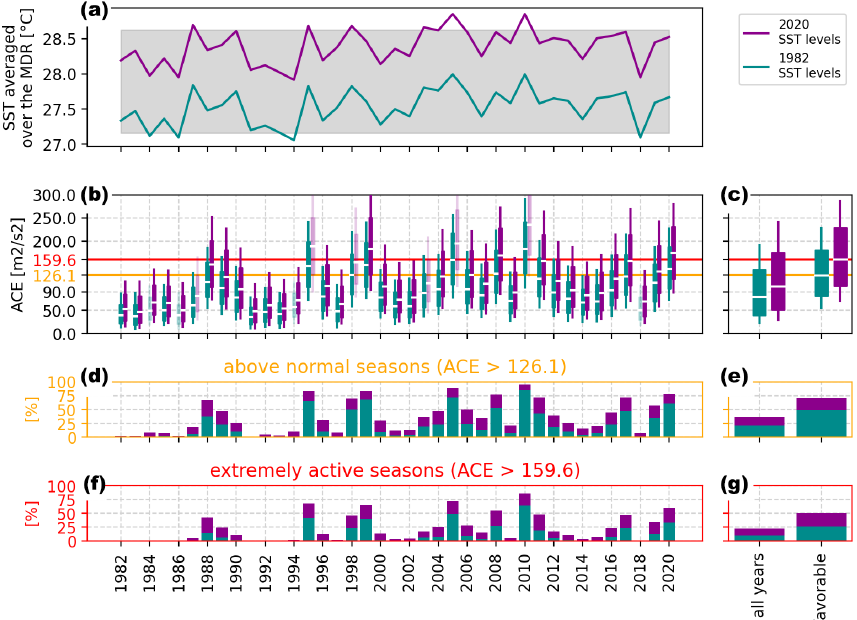
Figure 6. Atlantic hurricane seasons under different counterfactual SST scenarios. (a) Two counterfactual SST scenarios: SSTs from which the forced SST trend has been removed and that are shifted to 2020 SST levels (purple) and shifted to 1982 SST levels (cyan). The gray rectangle indicates the range of observed seasonal SST averages. See Fig. 5 for more details. (b) Simulations for the counterfactual scenarios of panel (a) displayed as boxplots. For years where the seasonal SST averages in the counterfactual scenario are outside of the range of observed seasonal SST averages, the simulations are shown in lighter shading. (c) Simulations for all years aggregated and for the most favorable years defined as years for which half of the simulations in the 2020 SST scenario have more than 126.1 ACE. (d) Probability of above-normal seasons (ACE > 126.1). (e) As panel (d) but for all years and favorable years. (f) As panel (d) but for extremely active seasons (ACE > 159.6). (g) As panel (e) but for extremely active